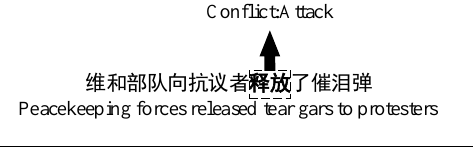
Figure 2. “ 这家公司并购了多家公司 ” and “ 那个受了伤的士兵不治身亡 ” represent Chinese